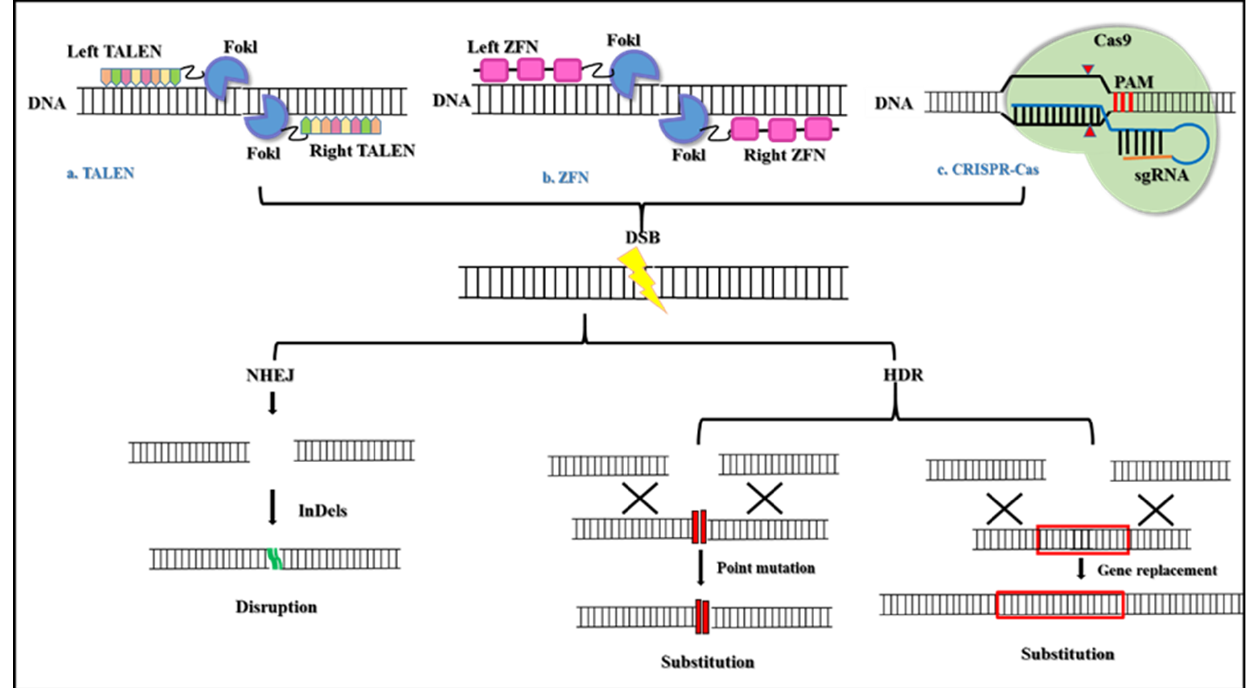
Figure 1. The basic mechanism of Genome editing tools. ( a ) TALEN is engineered endonuclease that are created by fusing a DNA-binding domain obtained from transcription activator-like effectors (TALEs) from Xanthomonas proteobacteria and the catalytic domain of FokI endonuclease. The TALEs consist of monomeric tandem repeats of amino acids that bind individually to each nucleotide in the target sequence. ( b ) ZFN has also engineered endonucleases that are generated by fusing the DNA-binding domain of zinc-finger proteins and the catalytic domain of FokI endonuclease. ZFN consists of three to six Cys2-His2 fingers that individually recognize a triplet codon. Both TALEN and ZFN on binding to DNA dimerize to cleave the DNA. ( c ) The CRISPR Cas systems are RNA-guided nucleases found in bacteria that cleave the DNA via RNA-DNA base-pairing. All three tools, TALEN, ZFN, and CRISPR Cas produced double-stranded breaks (DSBs) that are repaired by either non-homologous end joining (NHEJ) or homology-directed repair (HDR) to produce targeted mutagenesis and/or targeted gene substitution [25].